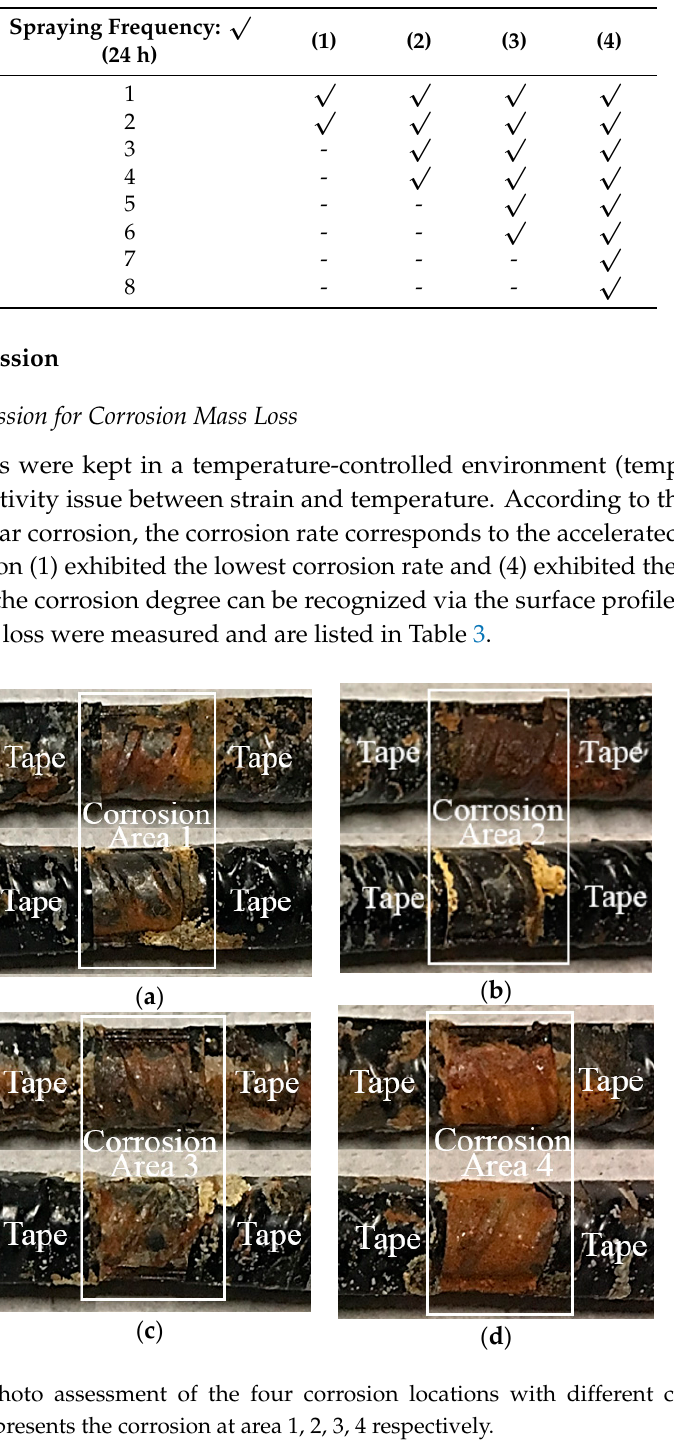
Table 2. Accelerated corrosion test scheme on the steel rebar.